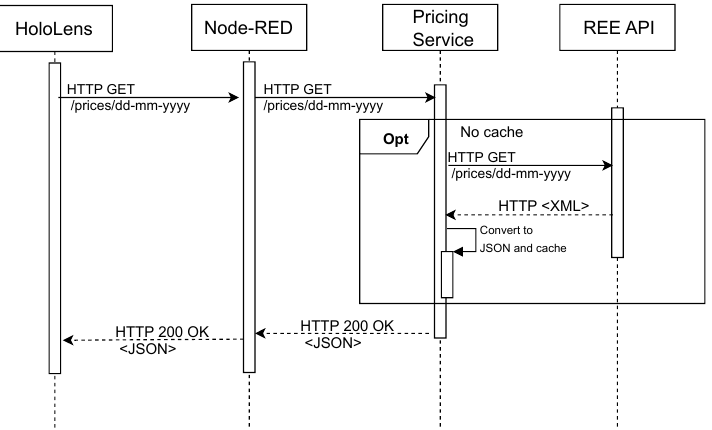
Figure 10. Sequence diagram for obtaining the energy cost per